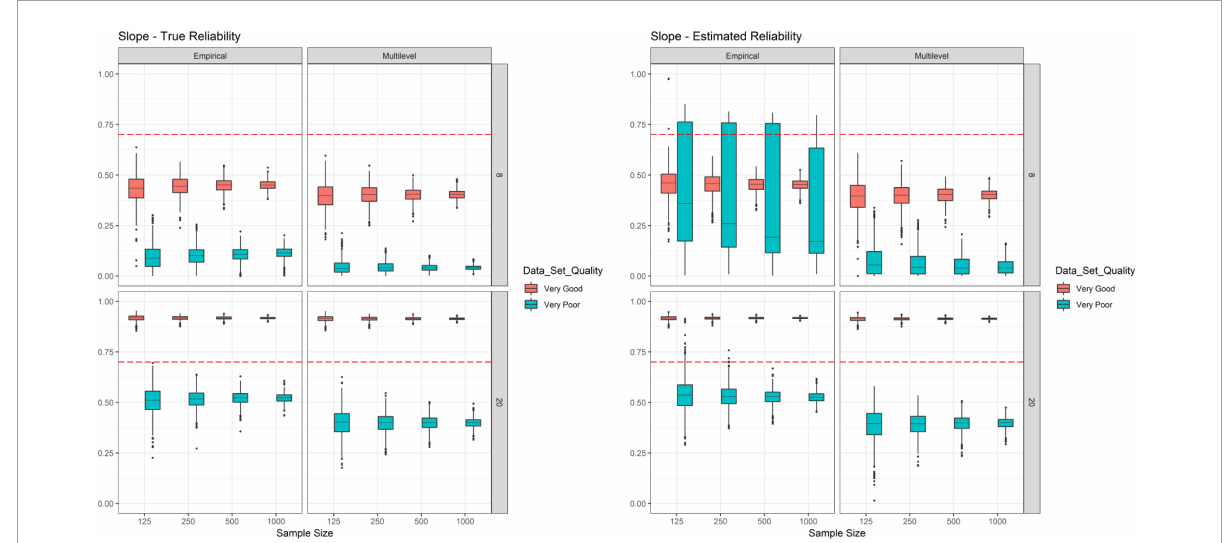
FIGURE2 Simulation study–true reliability and estimated reliability of slopes. Each box represents one cell of the simulation design and is based on 1,000